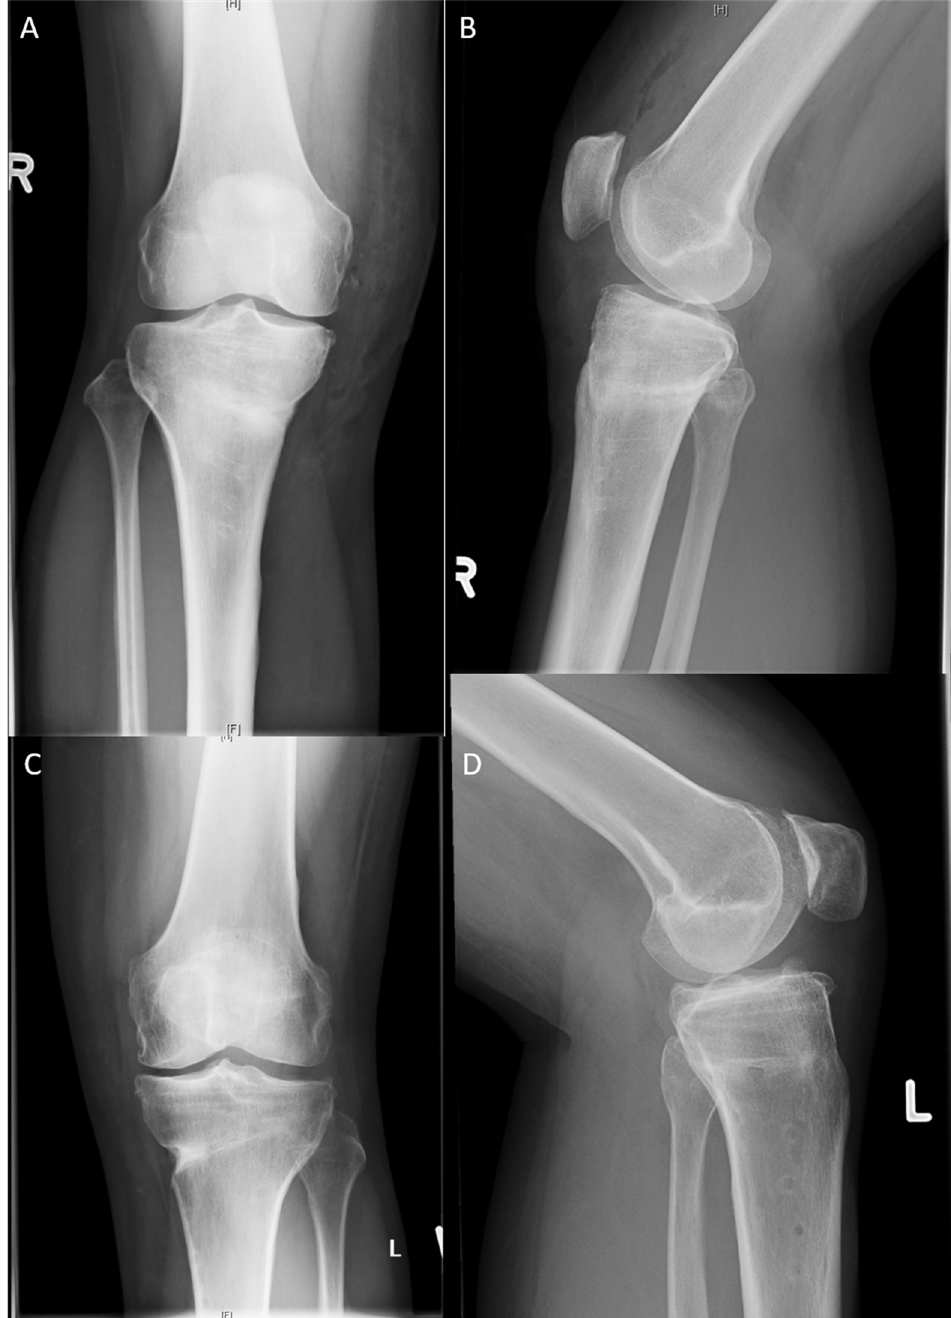
Figure 6. Post-operative X-rays after implant removal: ( A ) LOQTEQ ® HTO plate (aap Implants, Berlin), knee a.p.; ( B ) LOQTEQ ® HTO plate (aap Implants, Berlin), knee lateral; ( C ) TomoFix™ plate (Synthes, Switzerland), knee a.p.; ( D ) TomoFix™ plate (Synthes, Switzerland), knee lateral.